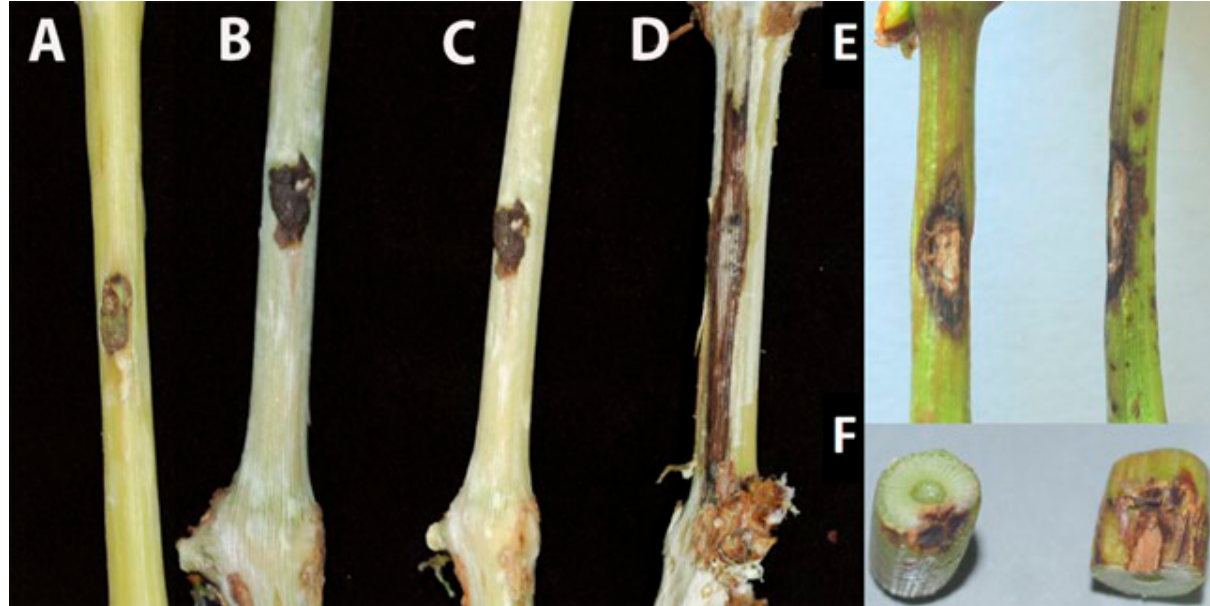
Figure 4. A-D: Grapevine dormant canes showing dark-brown lesions at 3 months after inoculation with: A, uncolonised plug of PDA as control; B, Eutypella microtheca isolate BCMX01; C, isolate BCMX02 and D, Lasidiplodia theobromae UCD - 256Ma. E-F, green shoots of dormant canes showing necrotic tissue 15 d after inoculation with isolates BCMX01 and